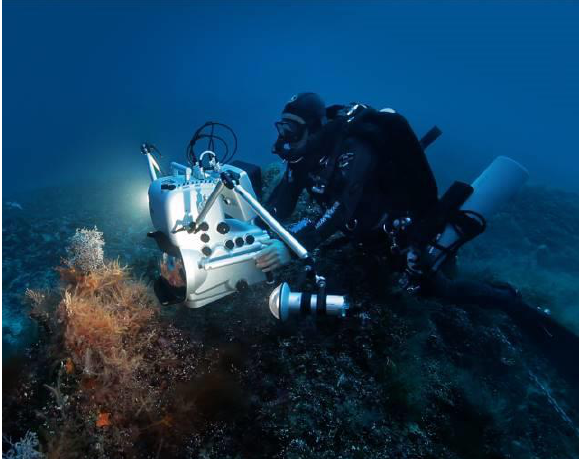
Figure 2. The housing used in Mediterranean: as it is possible to see and notice, the size is very small and the operator can work in the same time as cameraman and stereographer